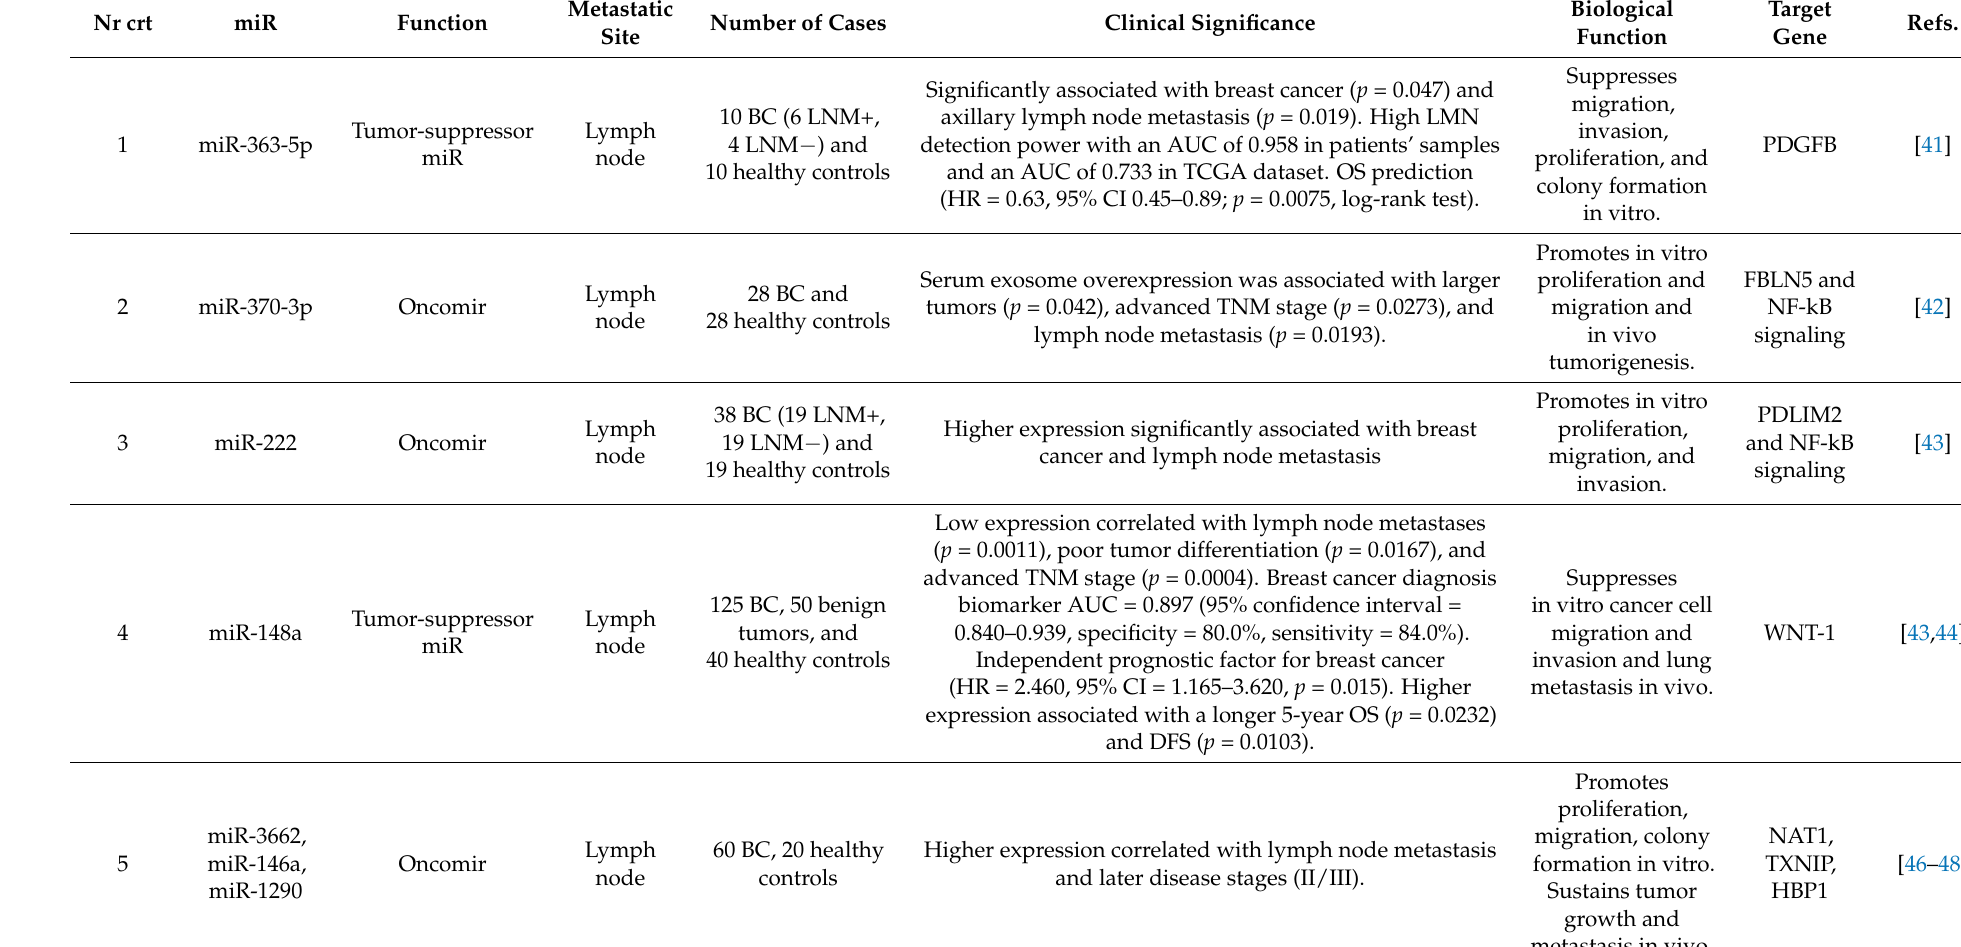
Table 1. Validated exosomal miRNA biomarkers useful for translational research with clinical applicability.